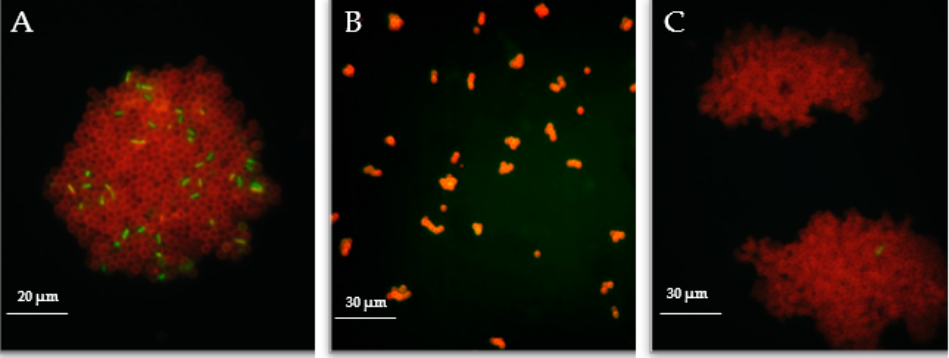
Figure 6. Characteristic images of MB clusters derived from urine samples: positive urine sample showing bacteria— E. coli captured with Anti E. coli MBs clusters ( A ), and negative urine samples with limited cluster formation ( B ) or with large nonspecific clusters with no bacteria present ( C ).